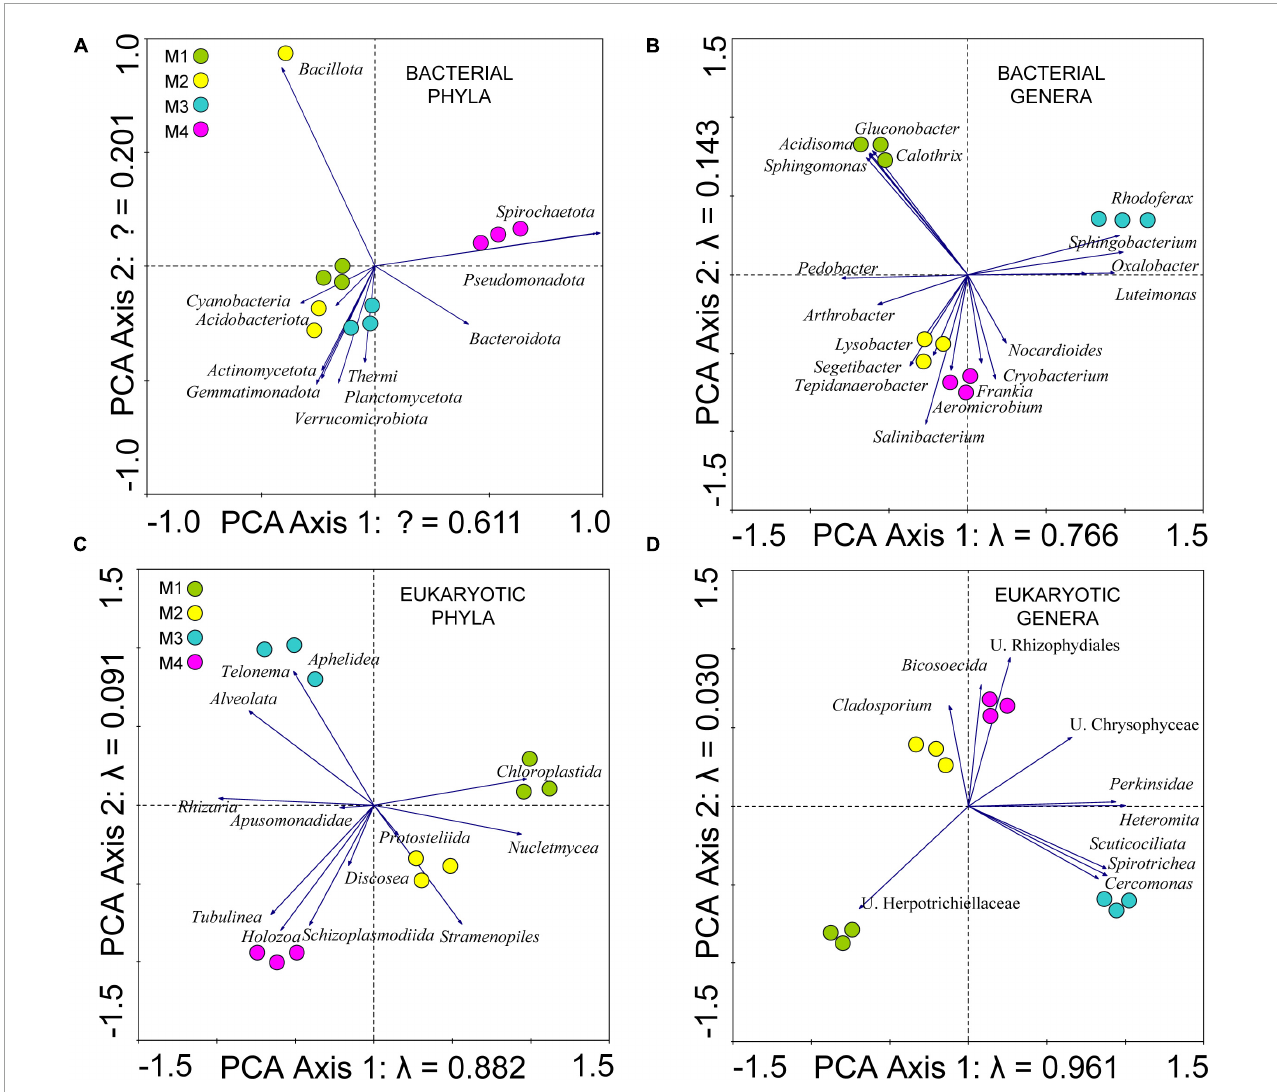
FIGURE4 Principal component analysis (PCA). Scatterplot of (A) bacterial phyla, (B) bacterial genera, (C) eukaryotic phyla, and (D) eukaryotic